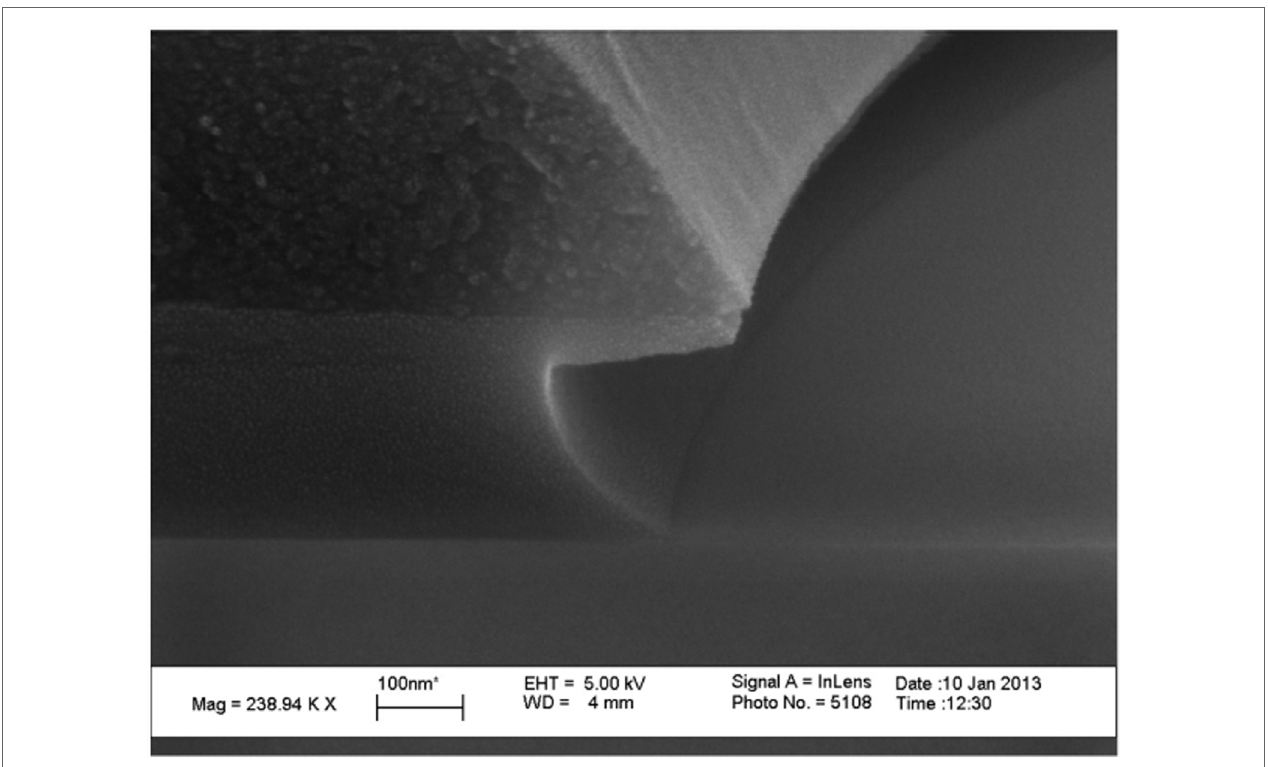
FiGURe 5 | SeM images of the organic-free quad layer lift-off pattern with SiO 2 /SiN/SiO 2 /Photoresist stack ready for thick metal evaporation